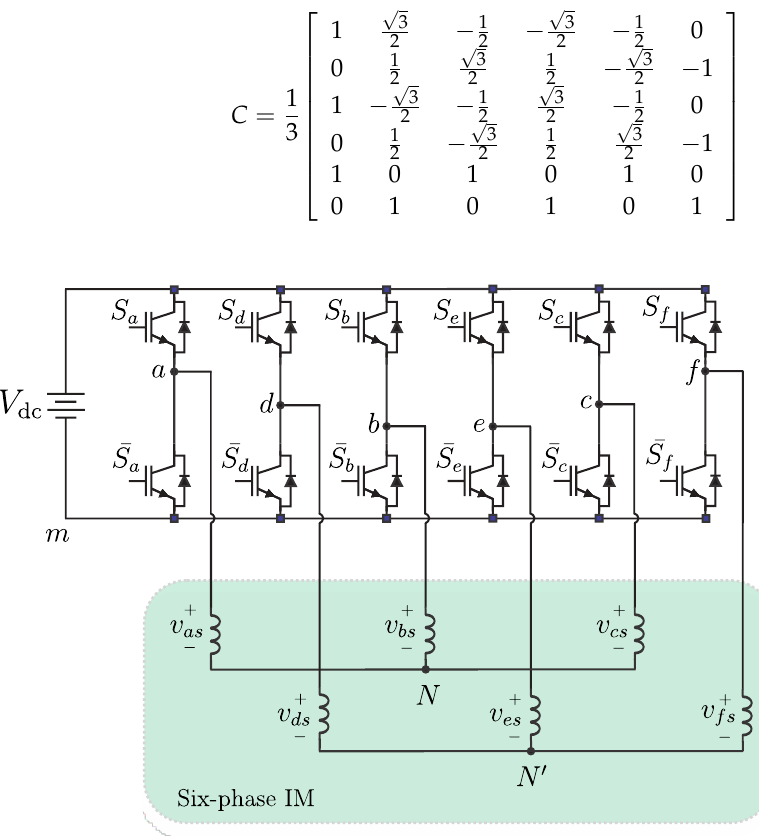
Figure 1. Six-phase IM fed by two level six-phase